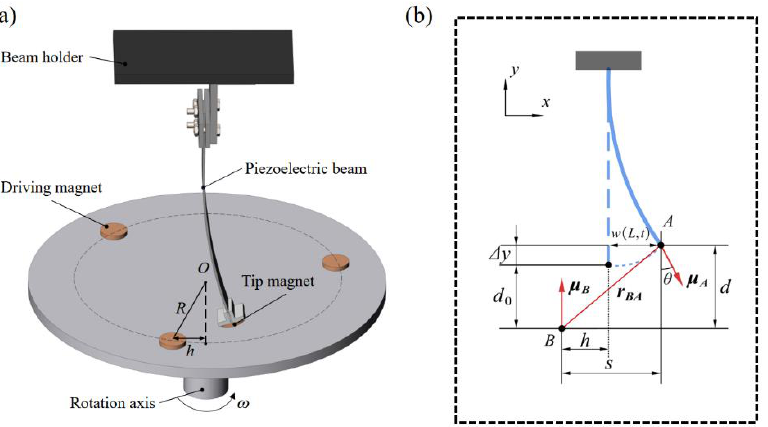
Figure 2. ( a ) Schematic diagram of the repulsive magnets; ( b ) the geometrical relations of magnets configuration via dipole-dipole methods.